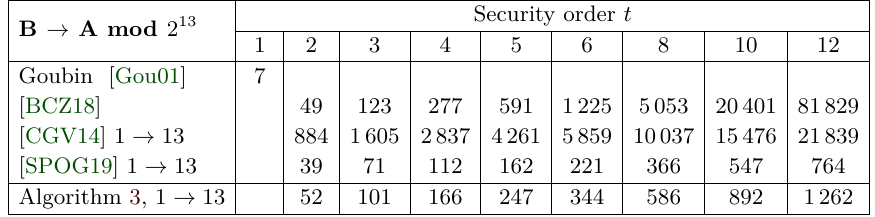
Table 3: Operation count for 1-bit Boolean to arithmetic modulo 2 k conversion algorithms, up to security order t = 12, with n = t + 1 shares, for k = 13.